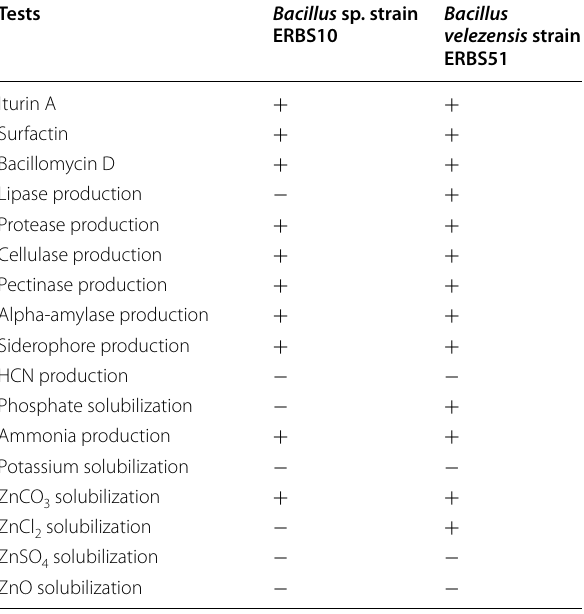
Table 2 Antimicrobial and plant growth promotion activity of the two test Bacillus strains